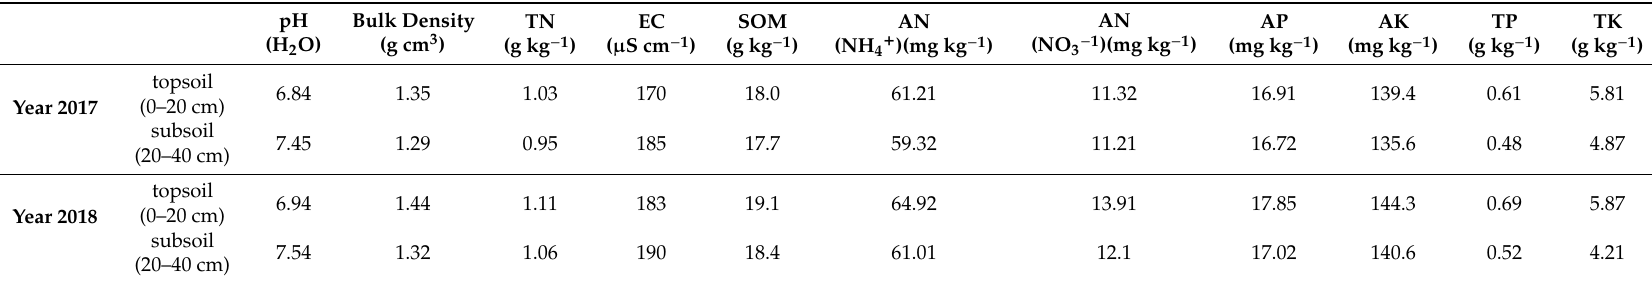
Table 1. Soil fertility status of the experimental site during 2017 and 2018. Data of soil samples collected from topsoil (0–20 cm) and subsoil (20–40 cm) depths before